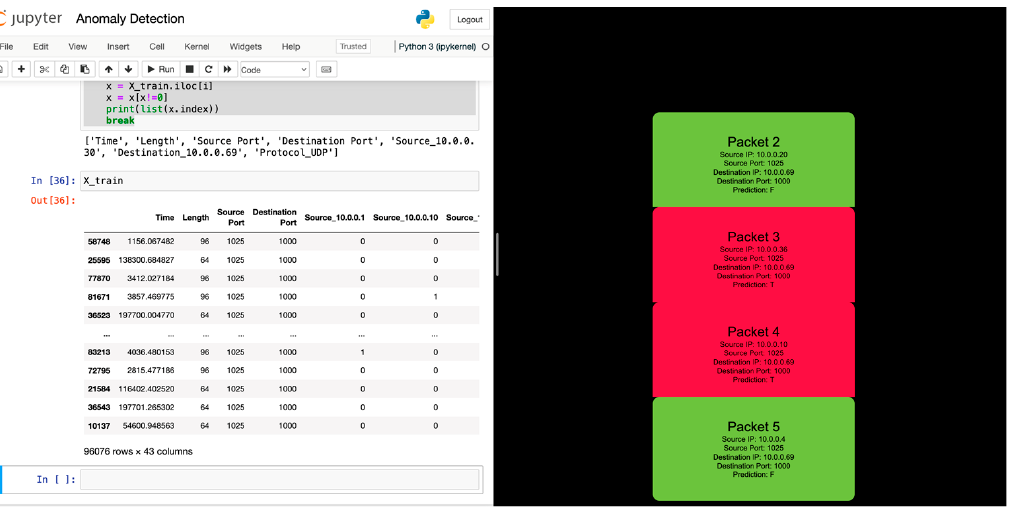
Figure 9. Visualization of the demonstrator based on random forest.